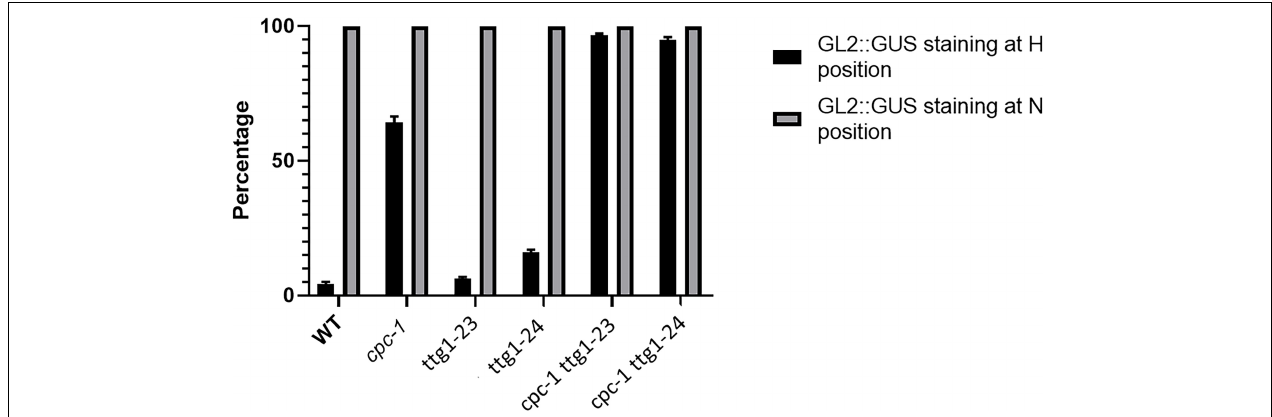
FIGURE 2 | Histograms of GL2:GUS expression in H-position and N-position root epidermal cells of WT, cpc-1 , ttg1-23 , ttg1-24 , cpc-1 ttg1-23, and cpc-1 ttg1-24 seedling root tips. Ten cells from each of the H and N positions in each root were measured. Ten seedling roots were analyzed for each replicate. Three independent biological replicates were performed for each genotype. Data shown are means